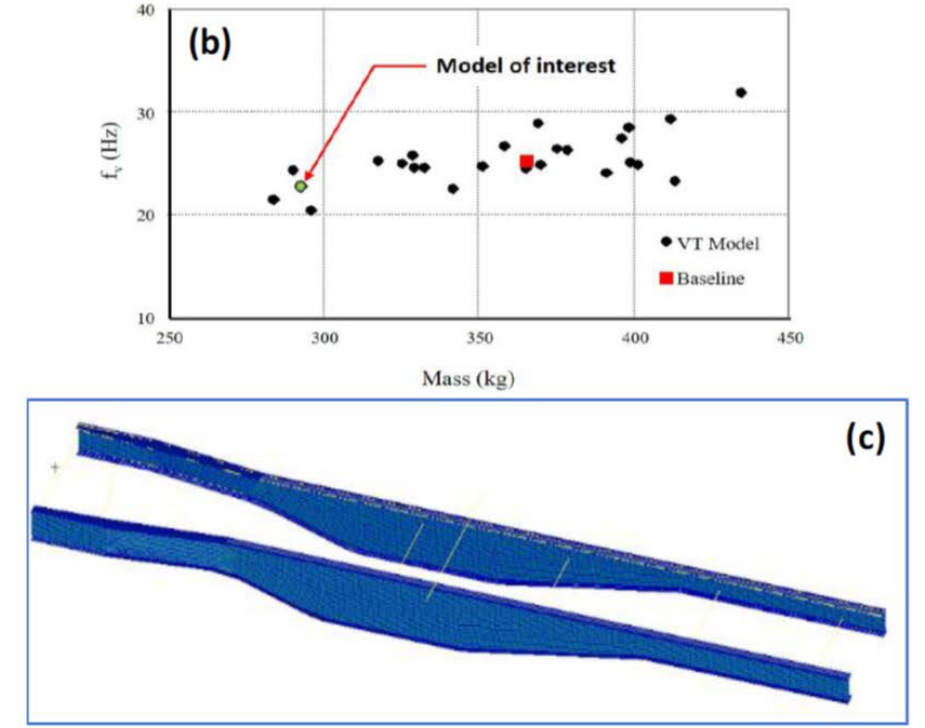
Figure 5. ( a ) Vertical bending stiffness vs. mass for random designs, ( b ) first vertical bending frequency vs. mass for random designs, and ( c ) the side rails of the model of interest (lower mass compared to baseline but with high vertical bending stiffness).